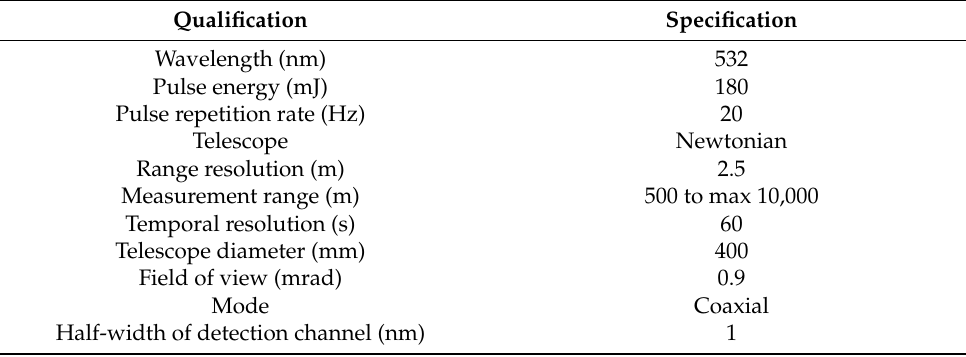
Table 2. The detailed specifications of the Mie-scattering aerosol lidar system. Qualification